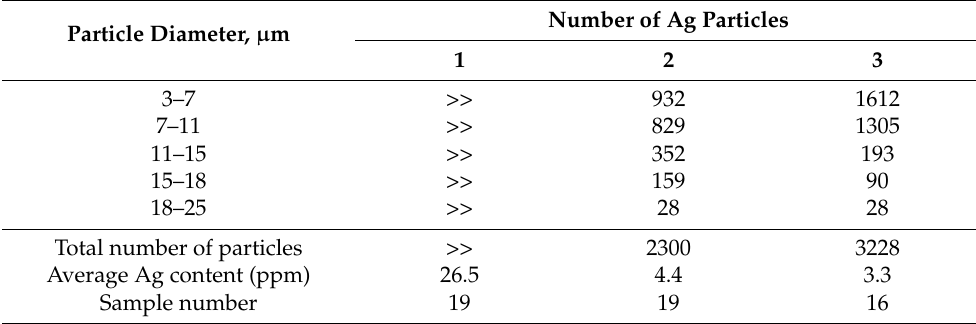
Table 5. The Piritovy Ag – Pb prospect. Distribution of Ag particles by diameter in bryolithochemical and lithochemical samples taken along a I-order watercourse (Pyritovy stream). Number of Ag Particle Diameter, µ m